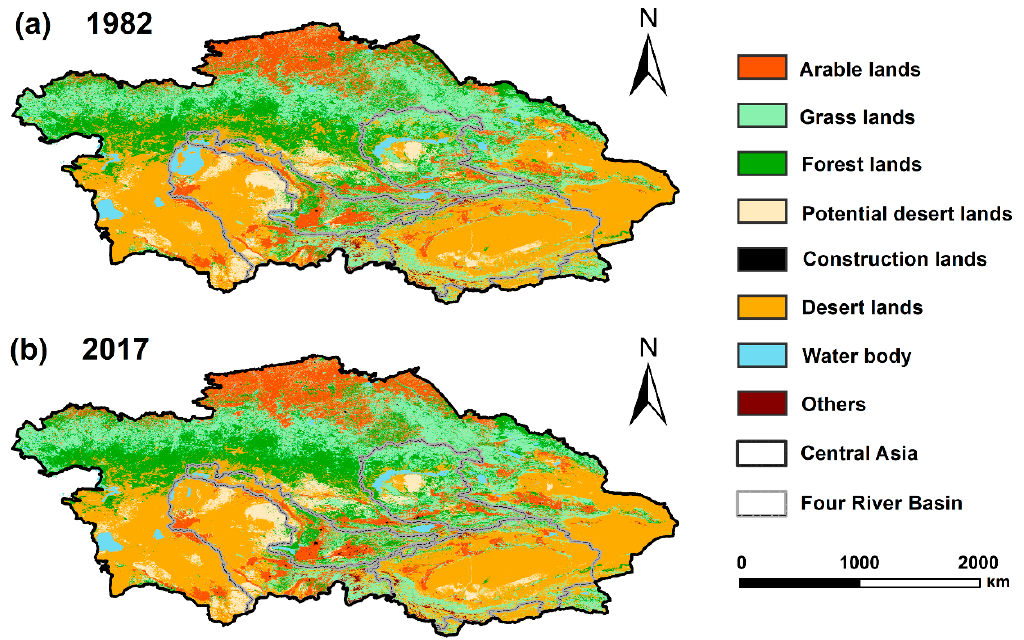
Figure 10. Land use classification for CA in ( a ) 1980 and ( b ) 2017. Table 1. Land use transfer matrix from 1982 to 2017 (km 2 ).